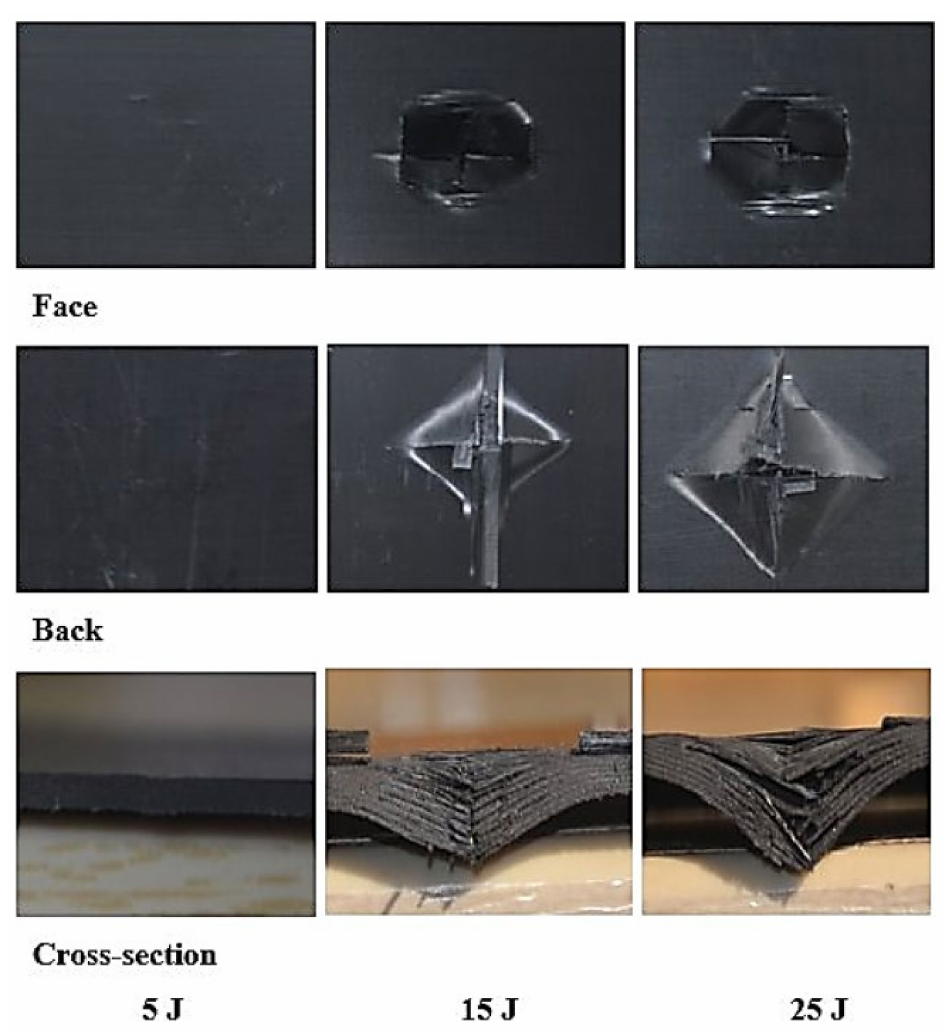
Figure 12. Pictures of the top and bottom surfaces and cross-sectional view of [B/B] at 5, 15, and 25 J.